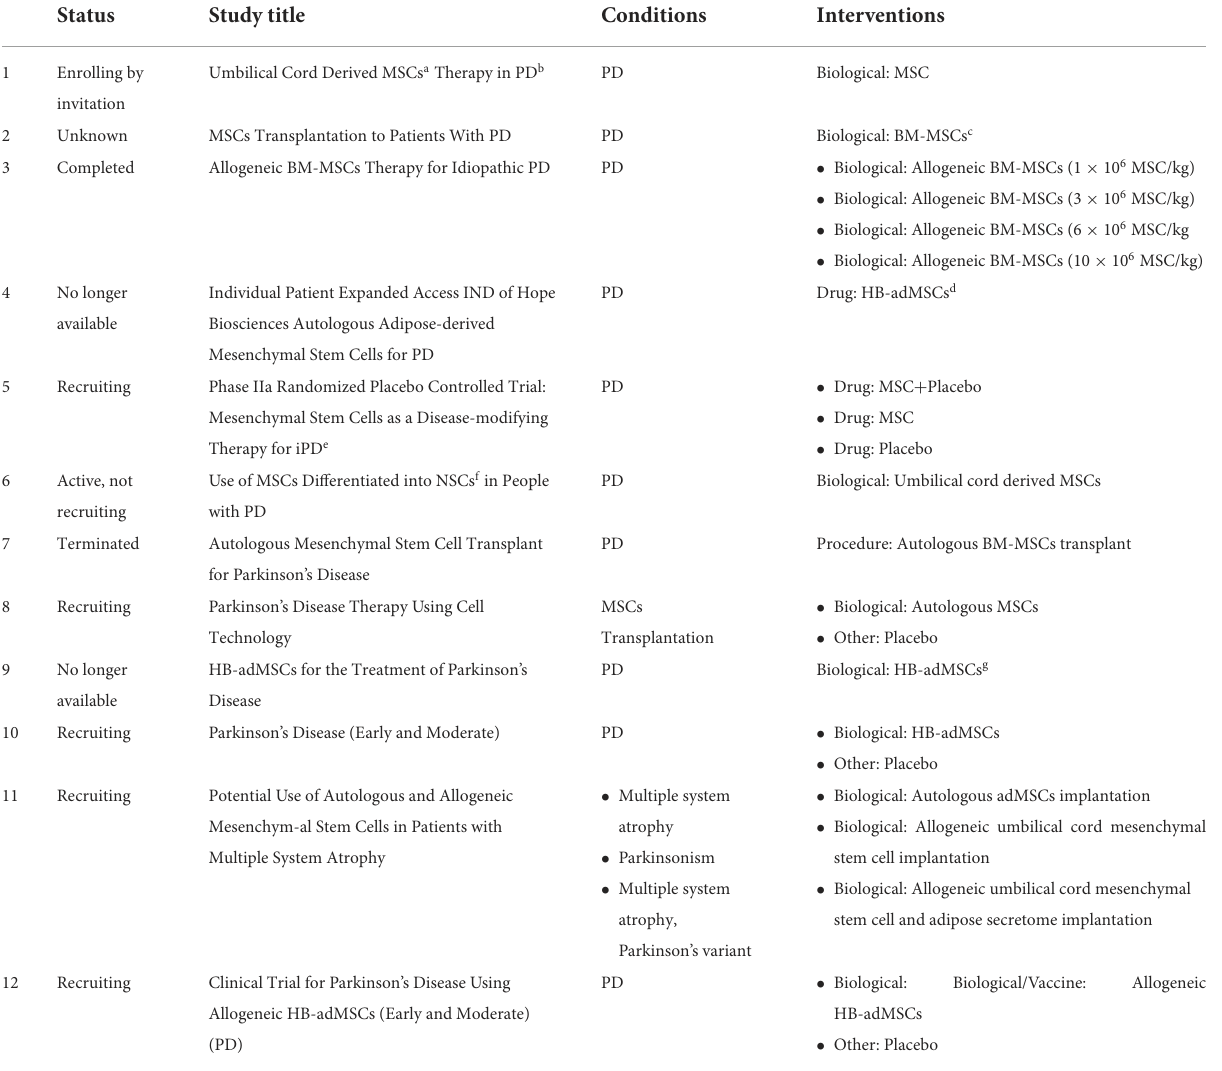
TABLE 1 Clinical trials using MSCs in the treatment of